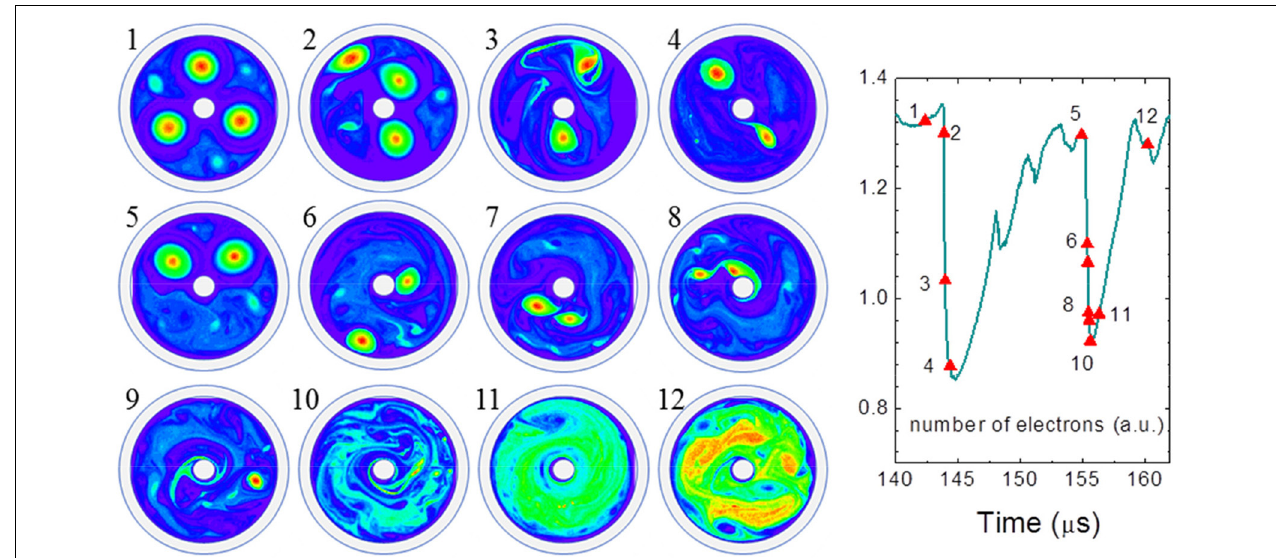
triangle symbol). The (min, max) range is (0, 3 × 10 15 m − 3 ) except for times 11, and 12, 13, where it is respectively (0, 1 . 5 × 10 15 m − 3 ) and (0, 10 15 m − 3 ) (Same color bar as Figure 3 ).